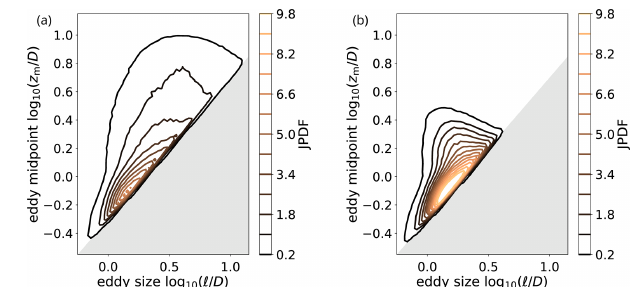
Figure 7. Joint probability density function (JPDF) of eddy size and midpoint for (a) weak and (b) strong stratification corresponding to the eddy event sequences of the cases W001 and S158 shown in Figs. 5d and 6d, respectively. ODT eddy events come close to but do not intersect with the surface, which is represented by the diagonal. The shaded region is physically forbidden as it would require eddies to cross the surface.